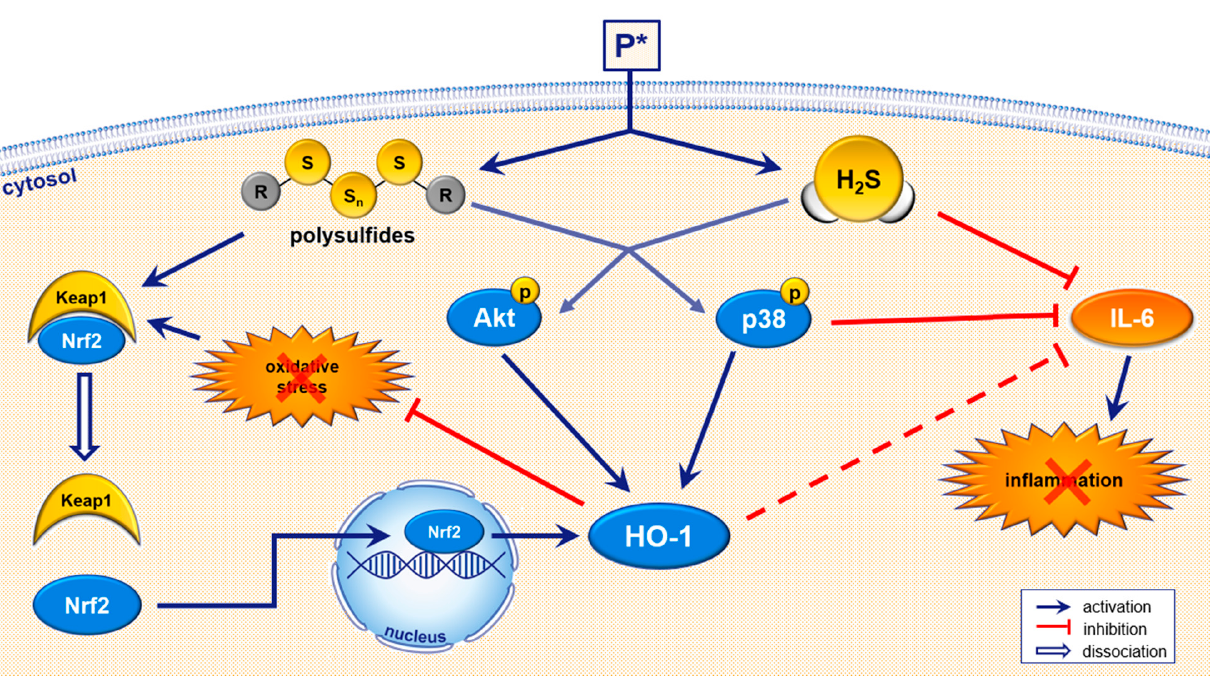
Figure 10. Schematic summary of P*-mediated biological effects. In aqueous buffers, P* generates a metastable persulfide and a mixture of polysulfides as end-products [38]. Upon entry into the cell, P* also releases H 2 S in the presence of thiols such as cysteine or glutathione. Sulfhydration of proteins is mainly carried out by polysulfides, leading to the activation of Nrf2/HO-1 dependent antioxidant pathways. P* also induces HO-1 via the regulation of Akt and p38 MAPK. Apart from antioxidant effects, P* also shows anti-inflammatory properties such as the inhibition of IL-6 for which H 2 S and p38 MAPK seem to be responsible.